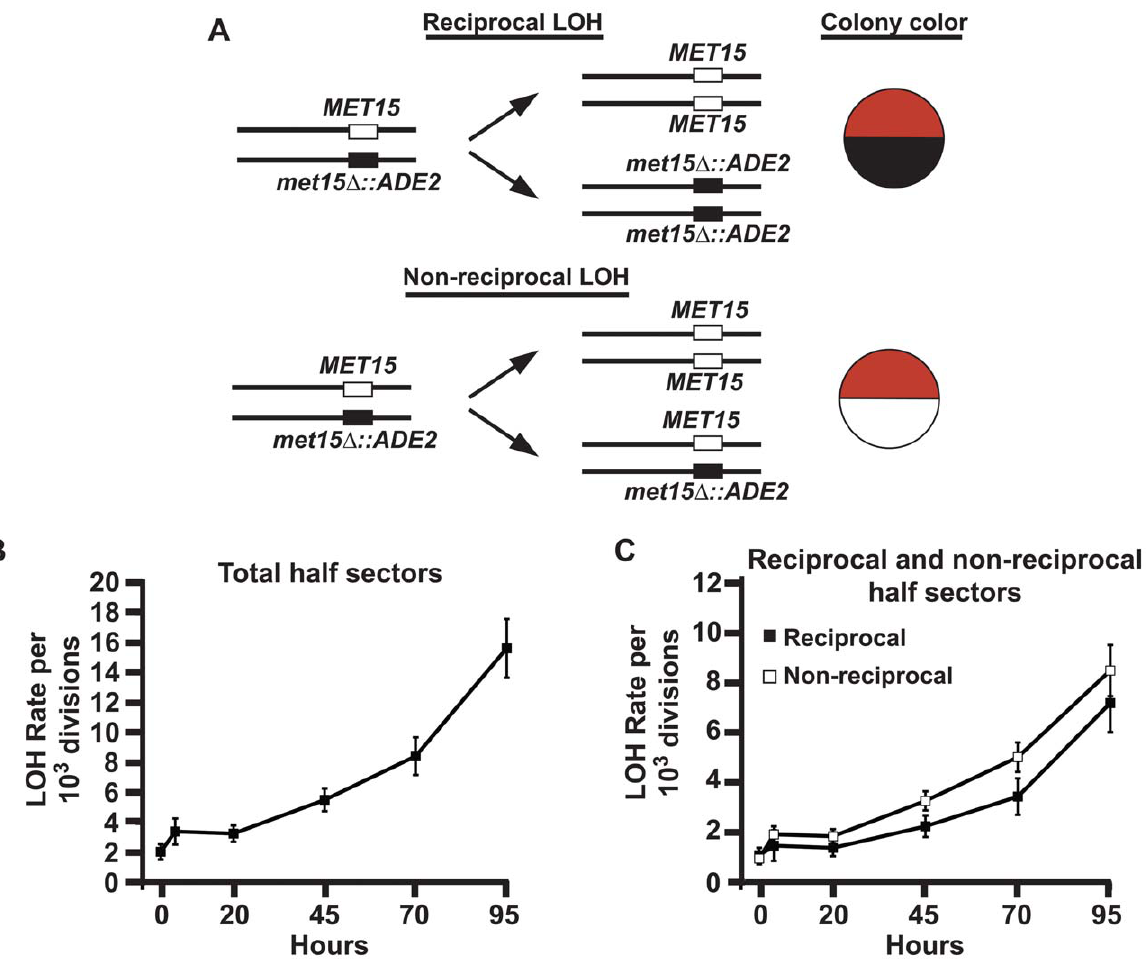
Figure 2. LOH rates at MET15 in aging cells present a constant ratio of reciprocal/non-reciprocal events. A diagram of UCC5185 colony color markers located on Chromosome XII, with expected results of reciprocal and non-reciprocal LOH events. Non-reciprocal events can also lead to black/white half-sectored colonies. (Note: The normal chromosomal copies of ADE2 have been deleted.) B) LOH rates for UCC5185 at MET15 reported as total LOH events per cell division. Error bars indicate SEM. The sample size at each time point ranges from 21 to 28. LOH rates are significantly increased at 45, 70 and 95 hours, (unpaired t-test; P values are 0.0003, , 0.0001, and , 0.0001 respectively). C) LOH events from panel B segregated into reciprocal and non-reciprocal LOH rates. Error bars indicate